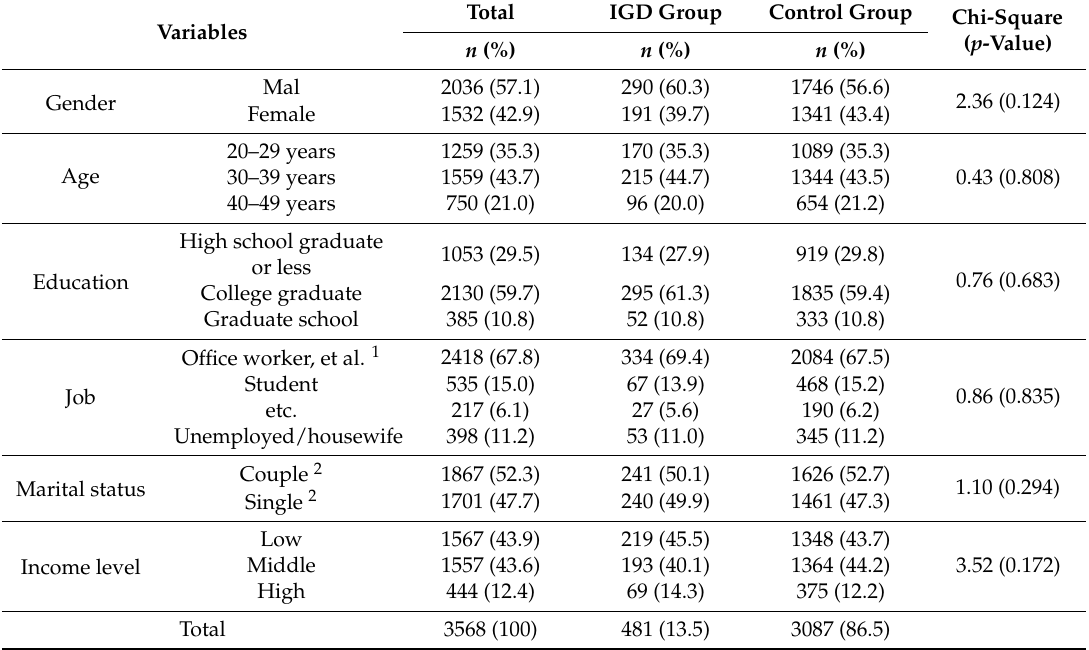
Table 2. Participants’